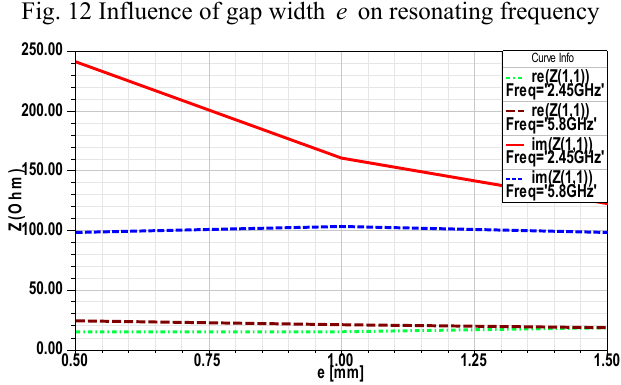
Fig. 13. Effect of gap width e on input impedance